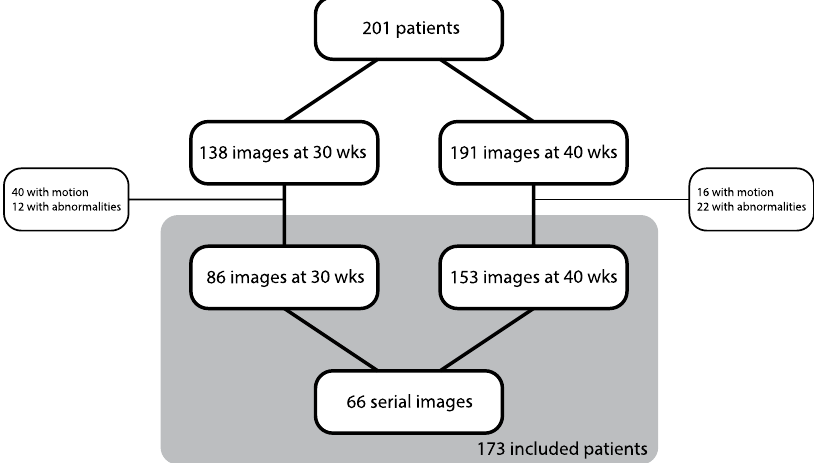
Figure 1. Exclusion of images because of motion artefacts or abnormalities that resulted in inaccurate automatic